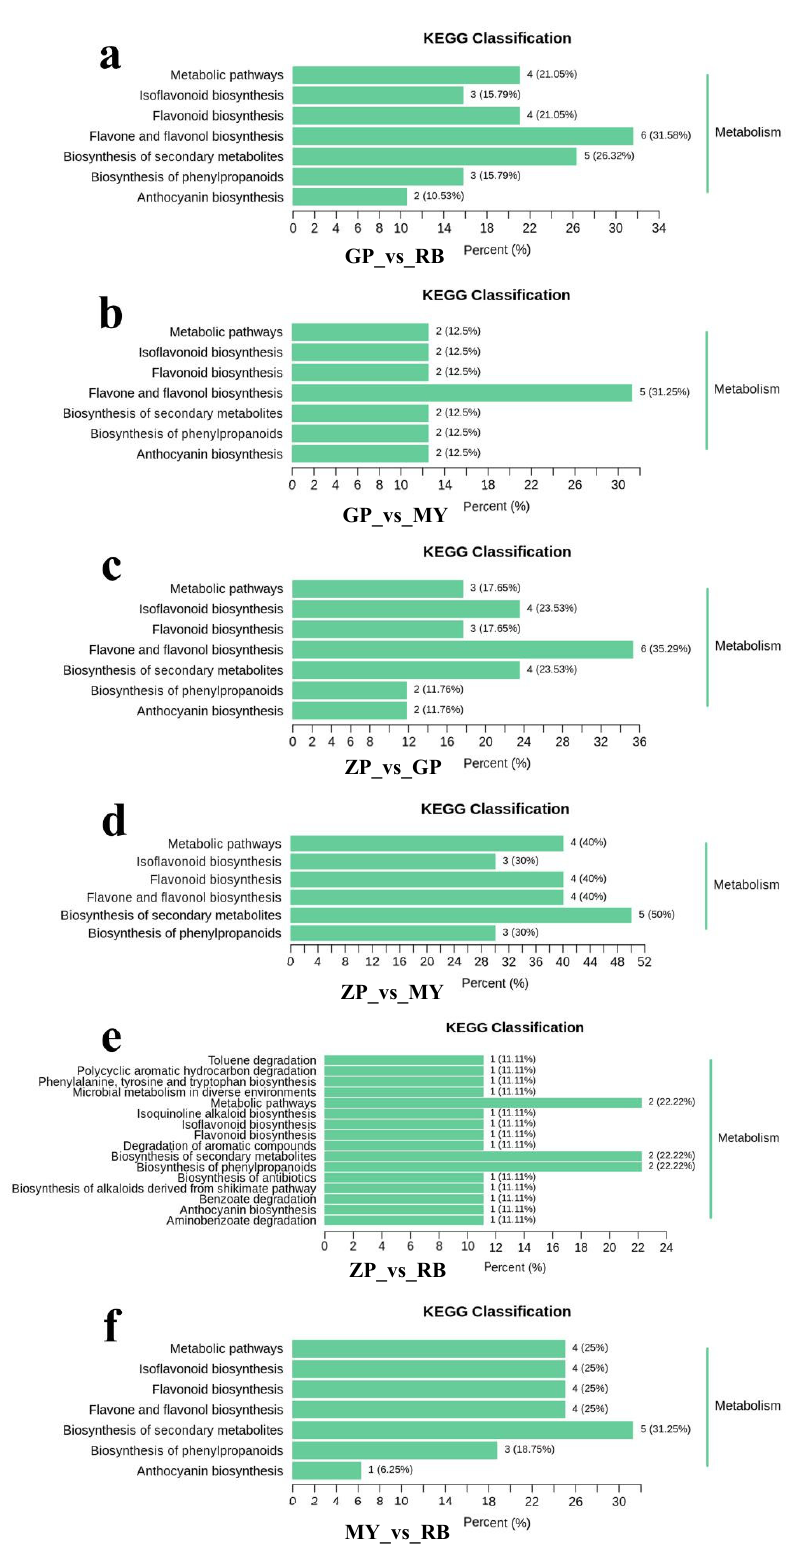
Figure 6. Kyoto Encyclopedia of Genes and Genomes (KEGG) pathway classification of comparison groups. ( a ) Comparison groups of GP and RB, ( b ) Comparison groups of GP and MY, ( c ) Comparison groups of ZP and GP, ( d ) Comparison groups of ZP and MY, ( e ) Comparison groups of ZP and RB, ( f ) Comparison groups of MY and RB.